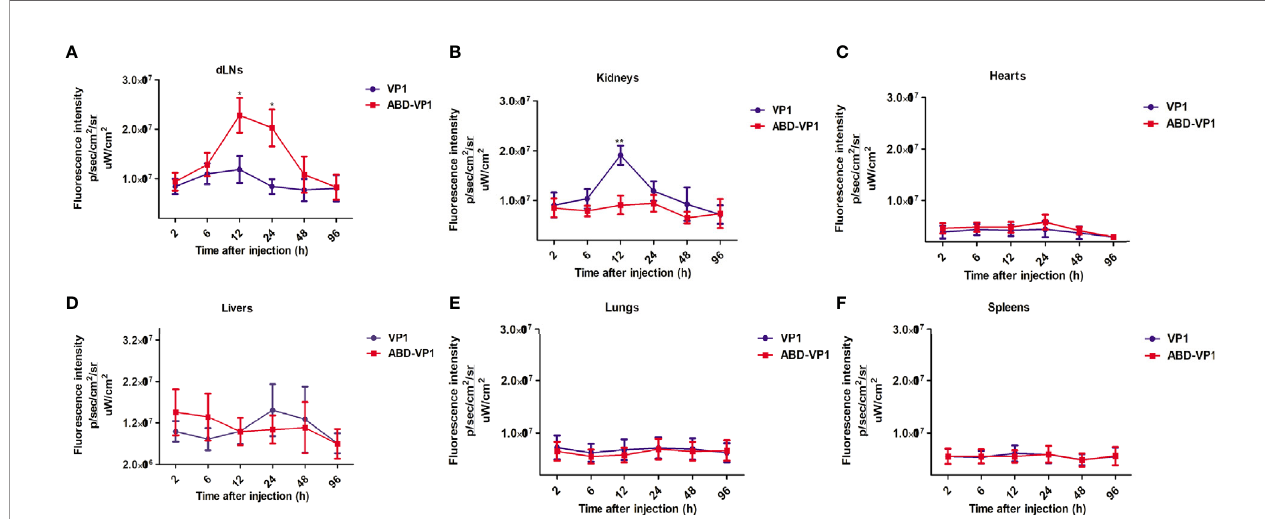
FIGURE 2 | The bio-distributions of ABD-VP1 and VP1 vaccines. Mice were subcutaneously given mCherry-fused ABD-VP1 or mCherry-fused VP1 vaccine, and the vaccine distributions in (A) dLNs, (B) kidneys, (C) hearts, (D) livers, (E) lungs, (F) spleens were analyzed by the bioluminescence imaging assays at the indicated time points. Each group contained 6 mice. *P < 0.05; **P < 0.01; ***P <